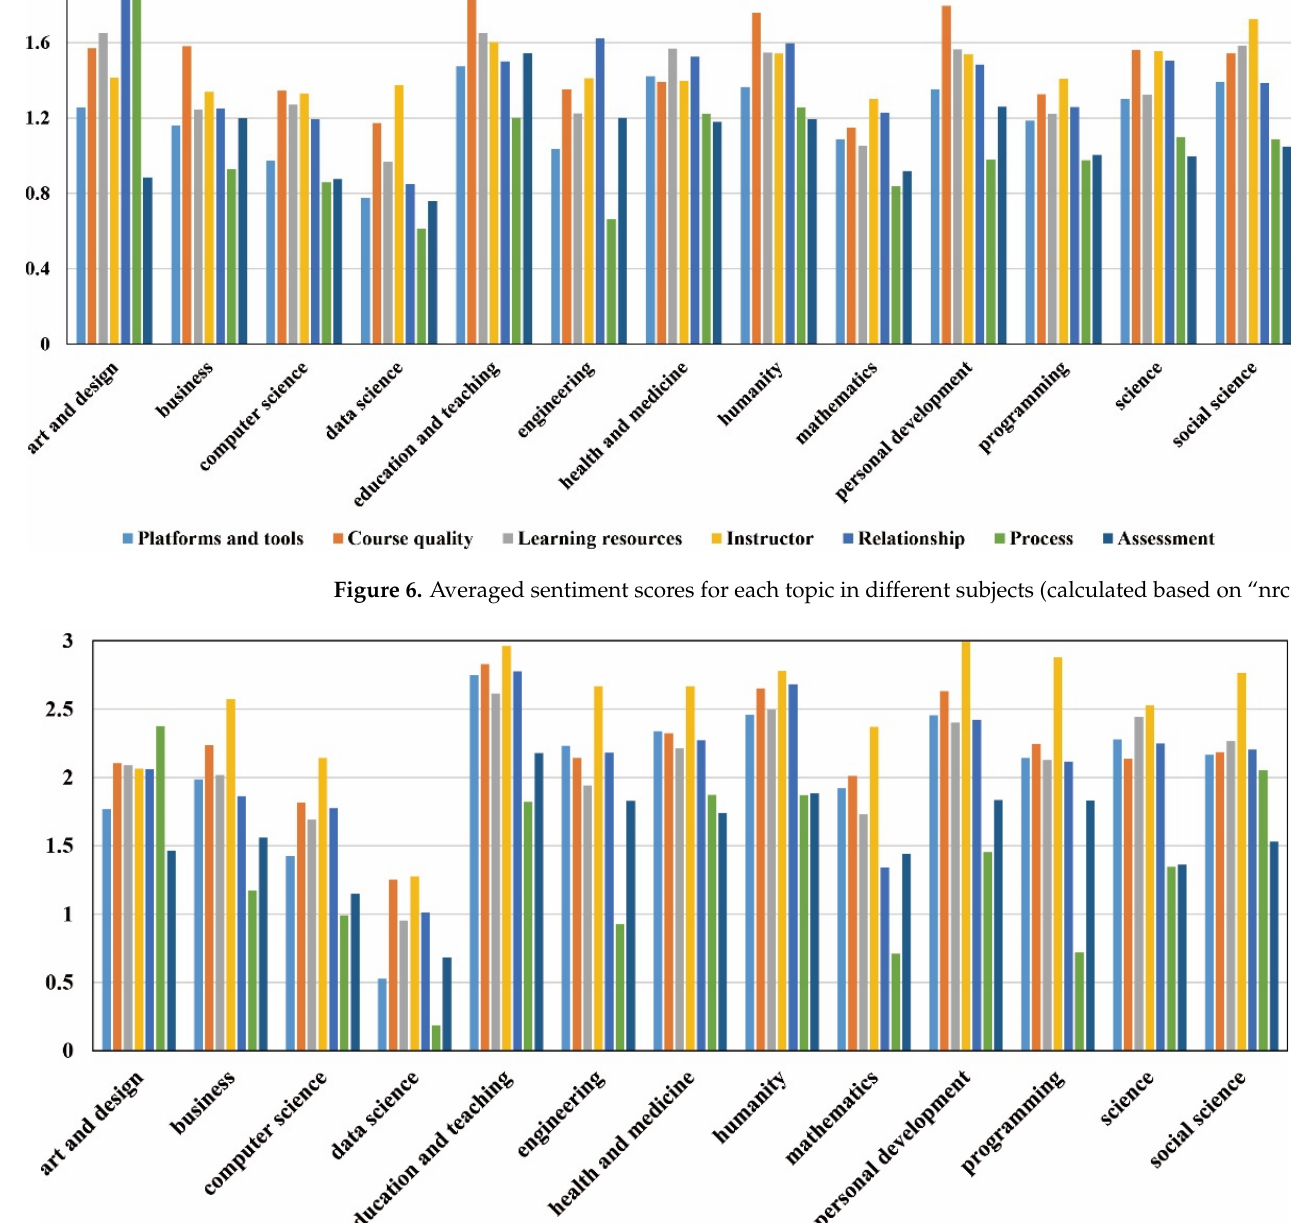
Figure 7. Averaged sentiment scores for each topic in different subjects (calculated based on “af- inn”).